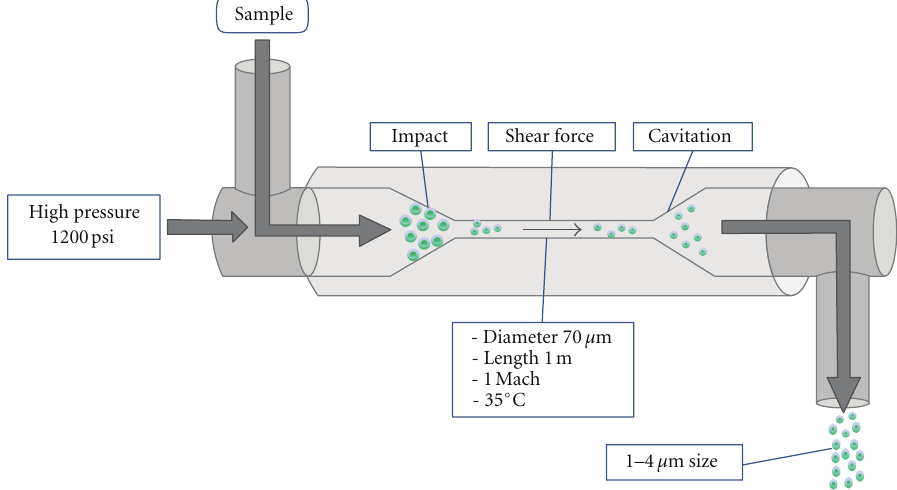
Figure 2: A schematic diagram of high-pressure homogenizer employed for pretreatment of algal biomass.